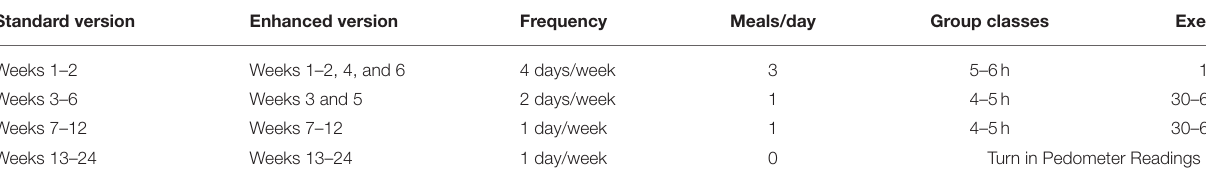
TABLE 1 | Standard and enhanced versions of the intensive lifestyle intervention.